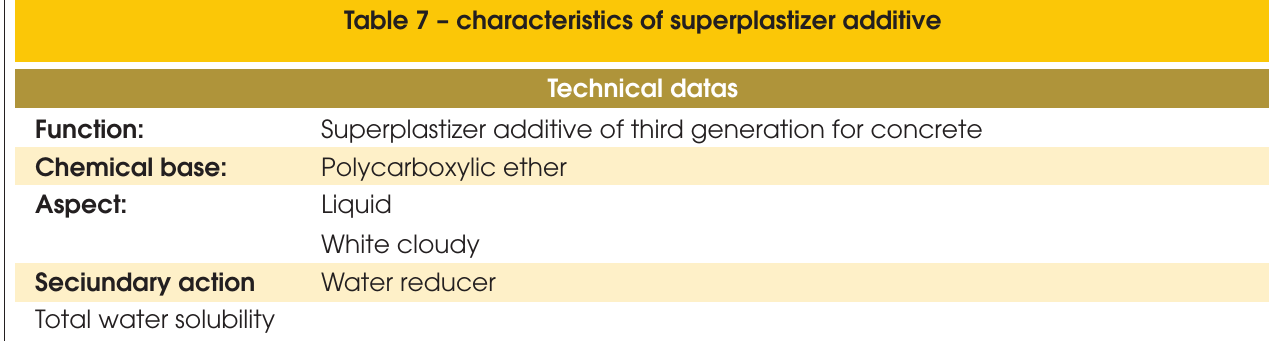
Table 7 – characteristics of superplastizer